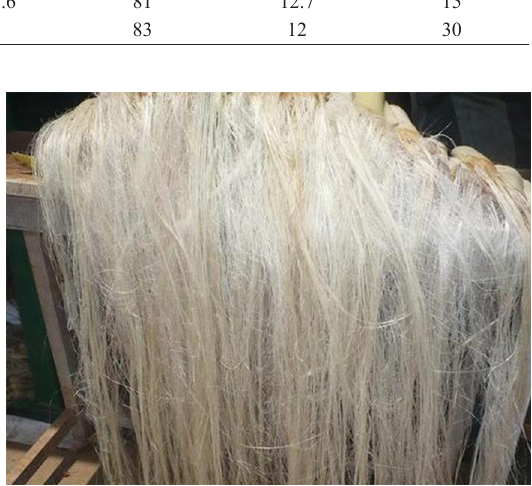
Figure 3. Pineapple fibers, PALF, extracted from the leaves of Ananas comosus .